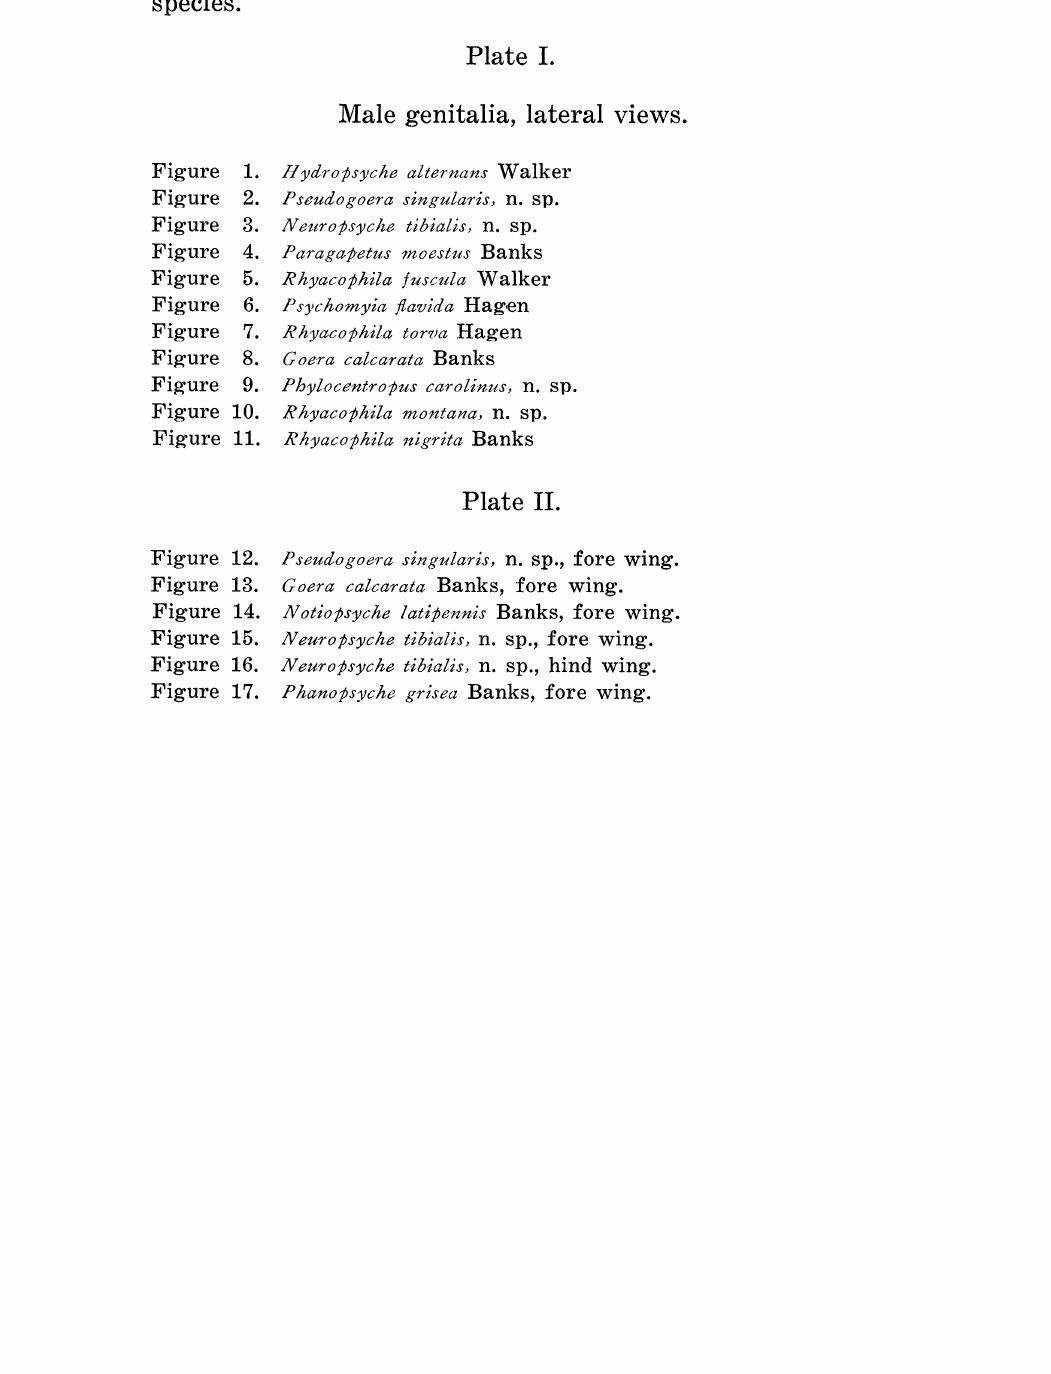
Pseudogoe,ra singularis, n. sp., fore wing. Goera calcarata Banks, fore